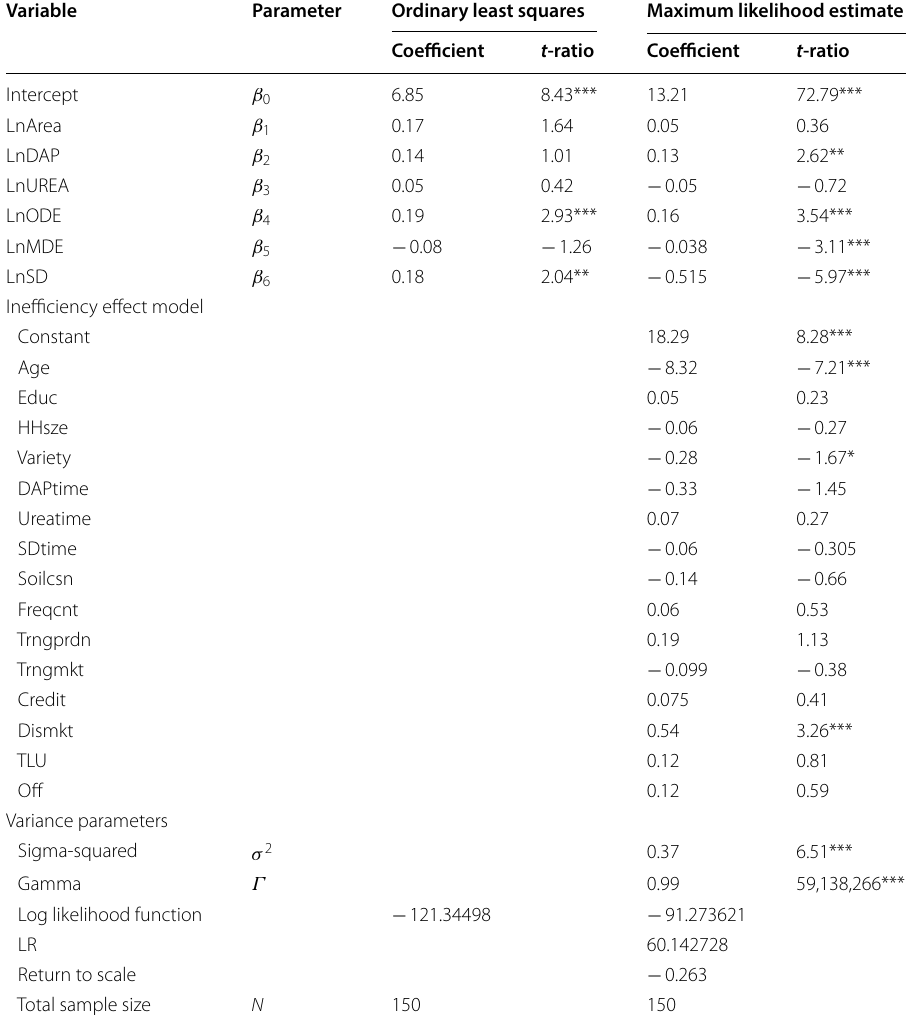
Table 8 The econometric parameters estimation results of the C–D and OLS. Source: Computed from Field Survey Data, 2015/16